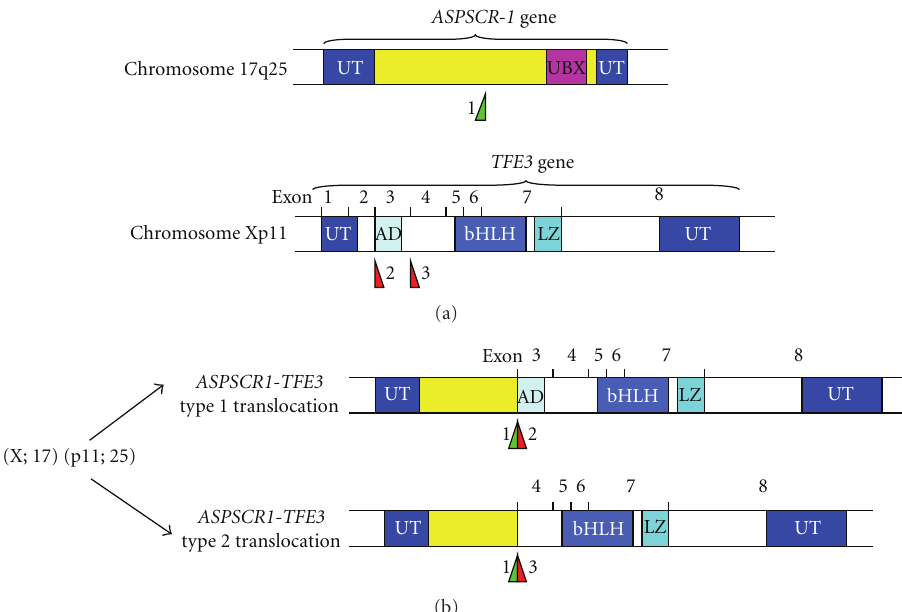
Figure 1: The t(X;17)(p11;25) translocation. (a) The ASPSCR-1 gene is located at chromosome 17q25 and the TFE3 gene at Xp11. The breakpoint found in the ASPSCR-1 gene is marked at “1”, and the two defined breakpoints in the TFE3 gene are marked “2” and “3”. (b) Following translocation, two variants of the ASPSCR-1-TFE3 fusion gene can be created. The Type 1 translocation retains the N-terminal activation domain of the TFE3